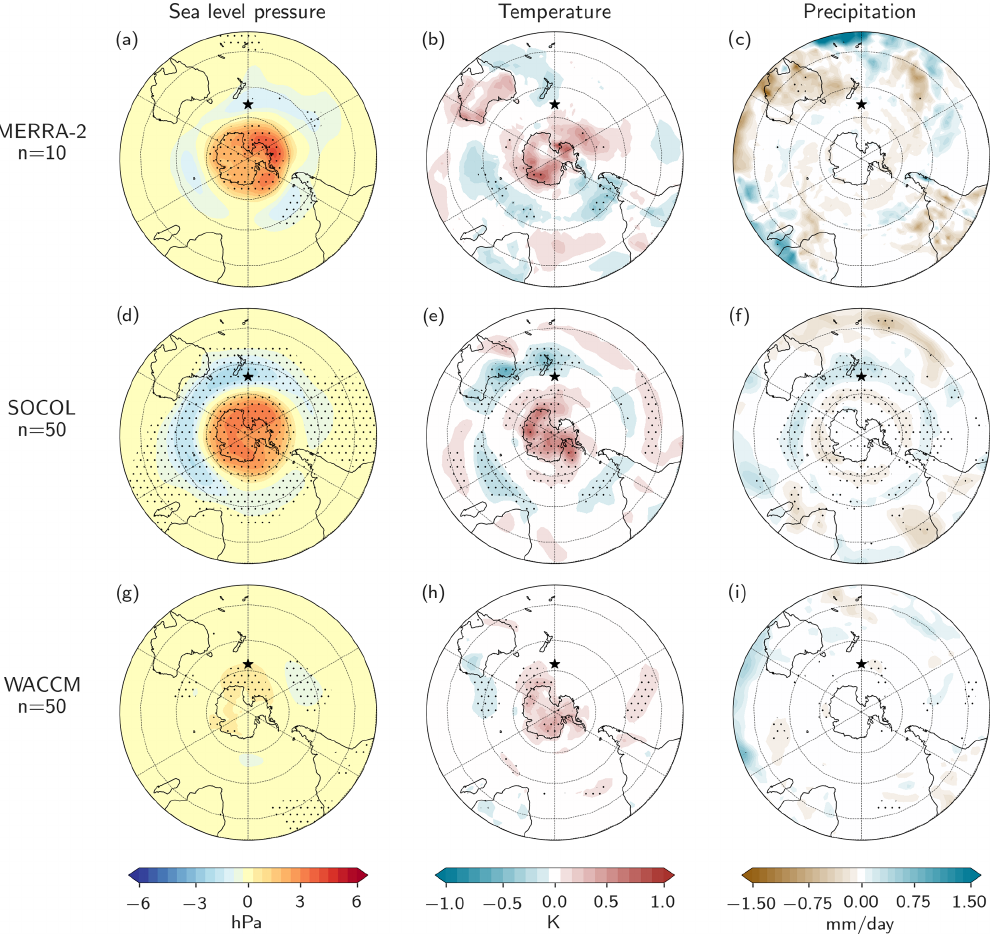
Figure 4. Surface climate composites for weak polar vortex regimes of October–January SLP anomalies (a, d, g) , 2m temperature anoma- lies (b, e, h) , and precipitation anomalies (c, f, i) . The reanalysis data MERRA-2 (a–c) includes 10 weak vortex regimes, and the CCMs SOCOL (d–f) and WACCM (g–i) each include 50 weak vortex regimes. Stippling refers to significance at the 4.5% level, assessed with a bootstrapping